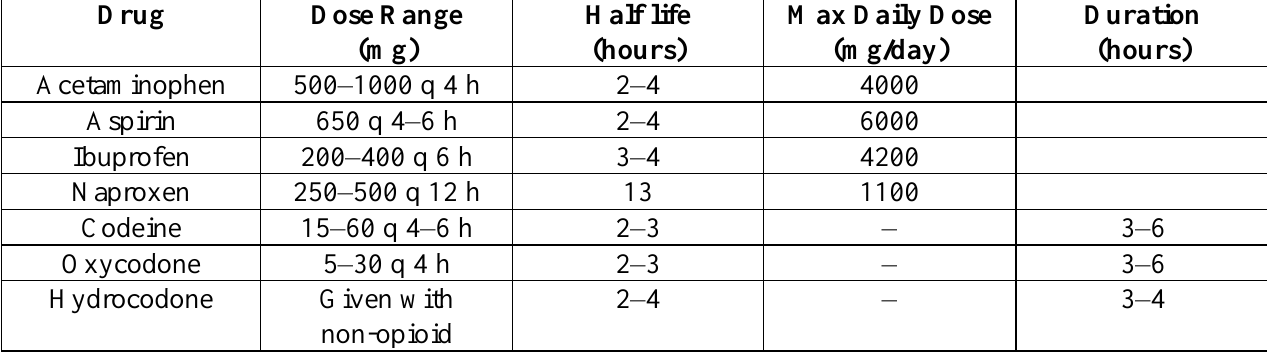
Table 1. Common Analgesics for Mild to Moderate Pain